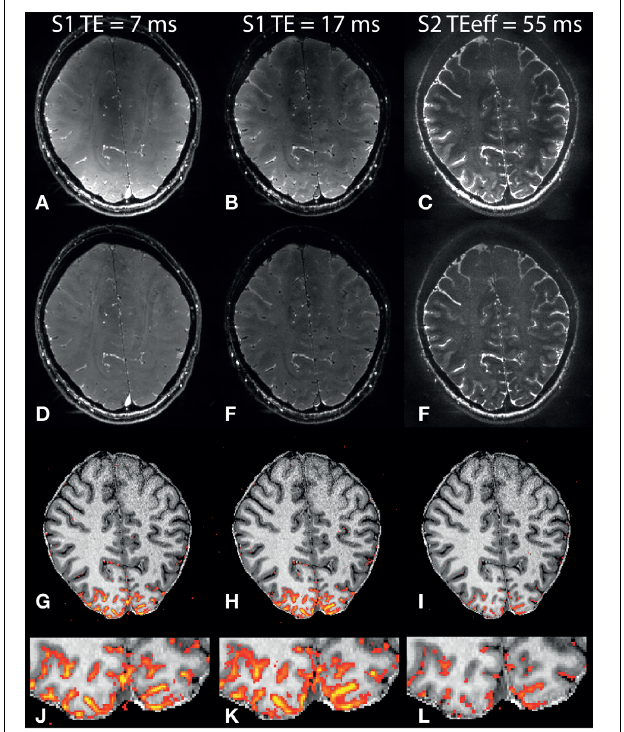
FIGURE 2 | Example nb-SSFP images and activation maps. Mean resting state images from one subject: (A) S1, TE = 7ms, (B) S1, TE = 17ms, (C) S2. (D–F) : Same as (A–C) after bias field correction. (G–I) : Anatomical image (MP2RAGE) overlaid with thresholded t -score maps for the first S1 (G) , second S1 (H) and S2 (I) echoes. (J–L) : Zoomed view of the same thresholded t -score maps. Color range for t -values is 2.3–10, and t -value images were smoothed using a gaussian kernel with SD = 0 . 65